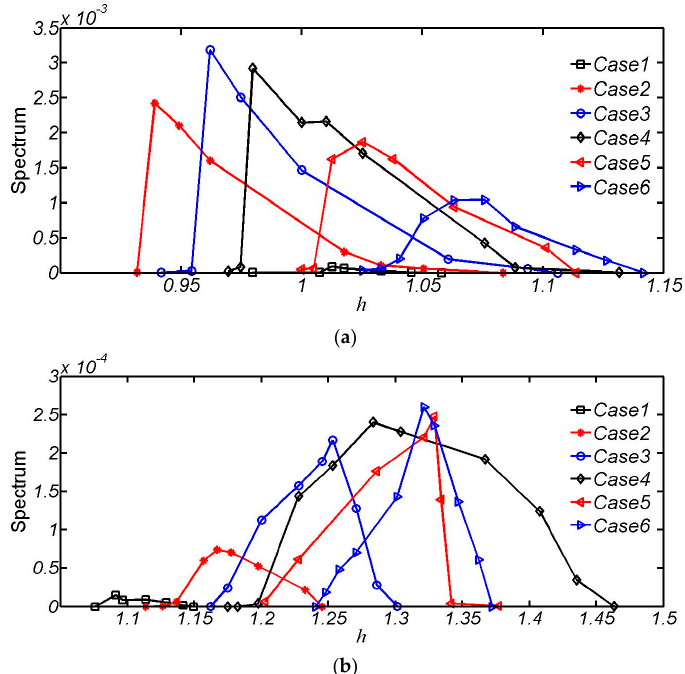
Figure 7. ( a ) Sloshing strength vs. water levels (in region 1); ( b ) Sloshing strength vs. water levels (in